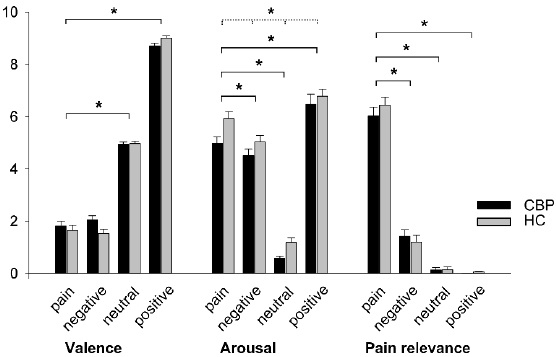
Figure 2. Mean ratings (standard errors) of valence, arousal, and pain relevance of each word category for CBP patients and HC. Valence (0 = “negative”; 10 = “positive”), arousal (0 = “no arousal”; 10 = “maximal arousal”), and pain relevance (0 = “not relevant”; 10 = “highly relevant”). Asterisks (*) indicate significant contrasts of Word Category (black line) and significant main effects of Group (dotted line).